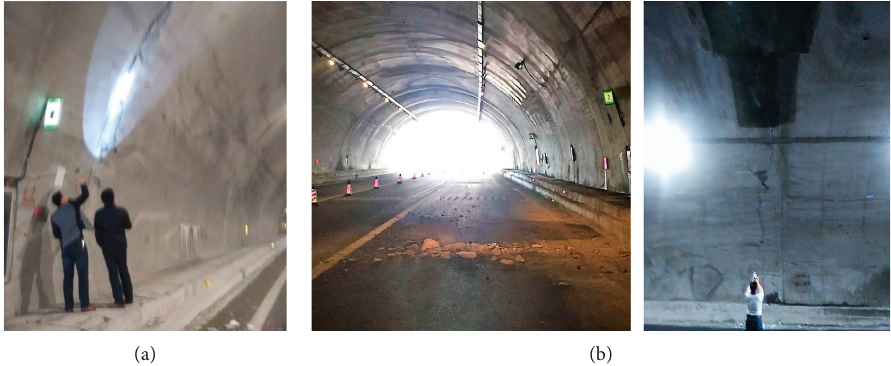
Figure 2: Crack of RK35 +268. (a) First cracked (November 15 2014). (b) Cracked after mended (June 9 2015).